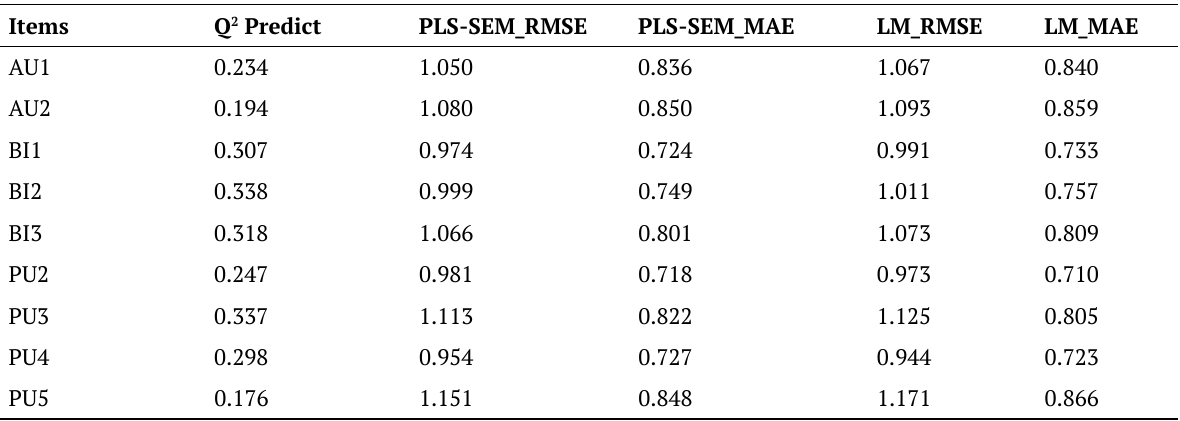
Table 7. Model’s Predictive power using PLSPredict